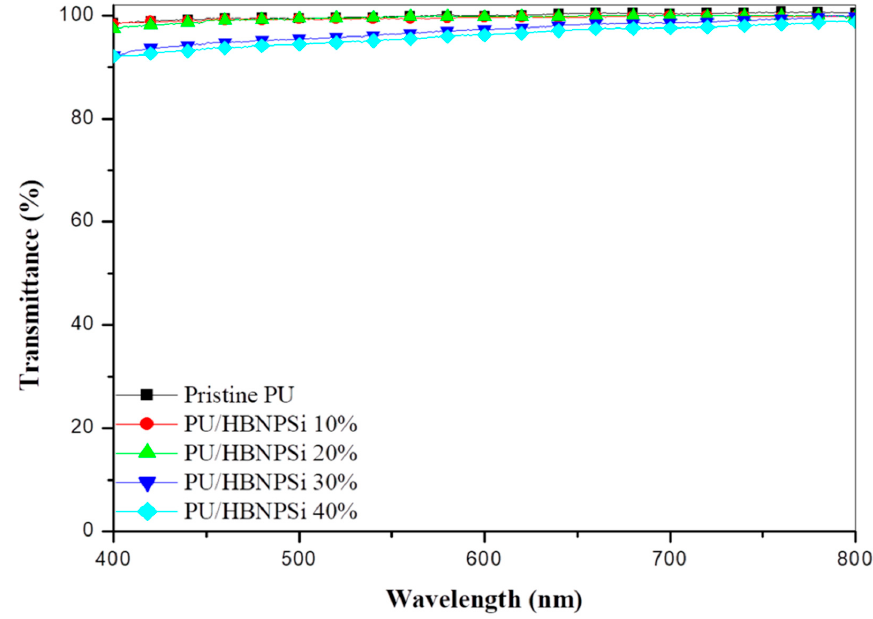
Figure 3. UV-VIS spectrum of pristine PU and PU/HBNPSi hybrid.